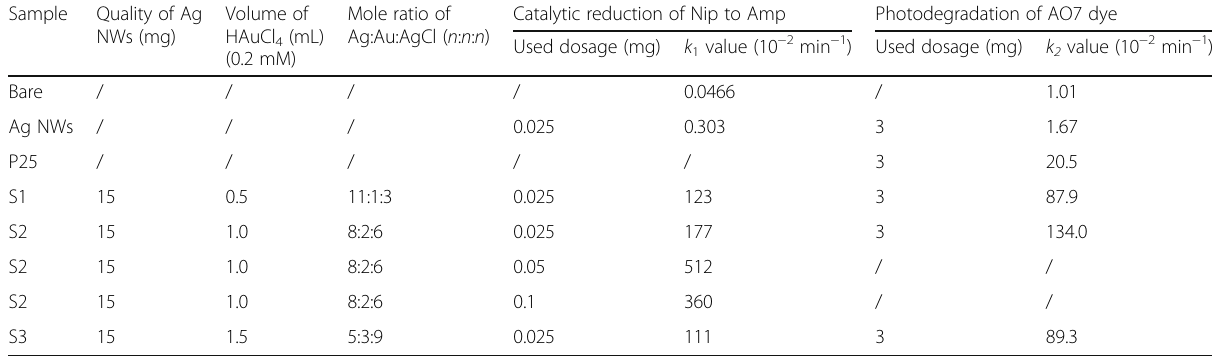
Table 1 Summary of the synthetic condition of samples and the kinetic rate constants ( k 1 ) for catalytic reduction of Nip to Amp, ( k 2 ) for photocatalytic AO7 dye under mix light